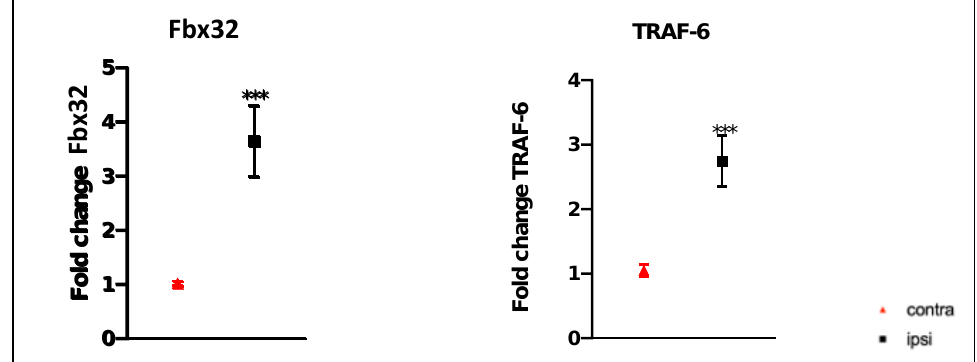
Figure 7. Results of real-time PCR. Fbx32 and TRAF-6 gene expression was higher in ipsilateral gastrocnemius muscle than in that in contralateral. Results are presented as fold change. ***: p < 0.001 vs. contra. Fold change values were calculated as 2 ΔΔCt .